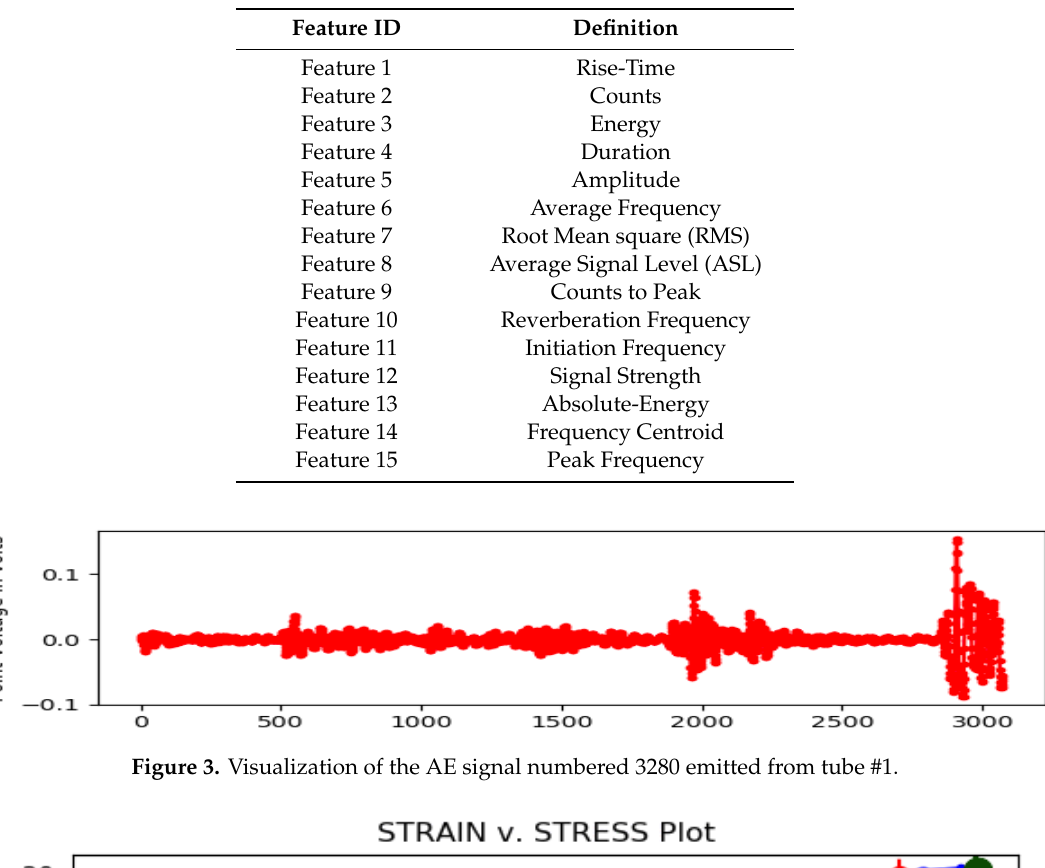
Table 1. Definition of acoustic emission signal features.